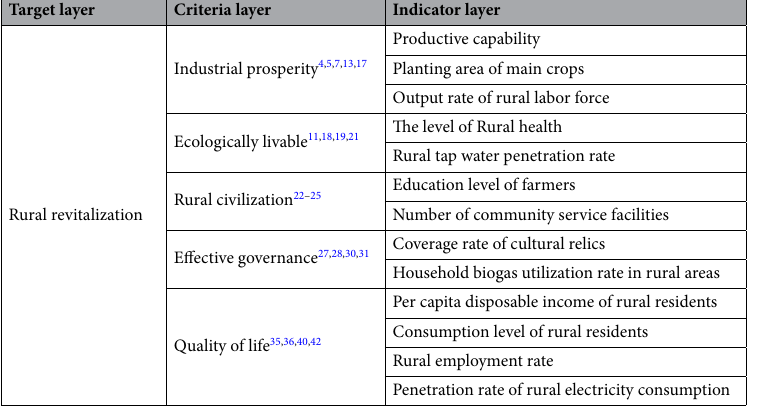
Table 1. Index establishment of Rural